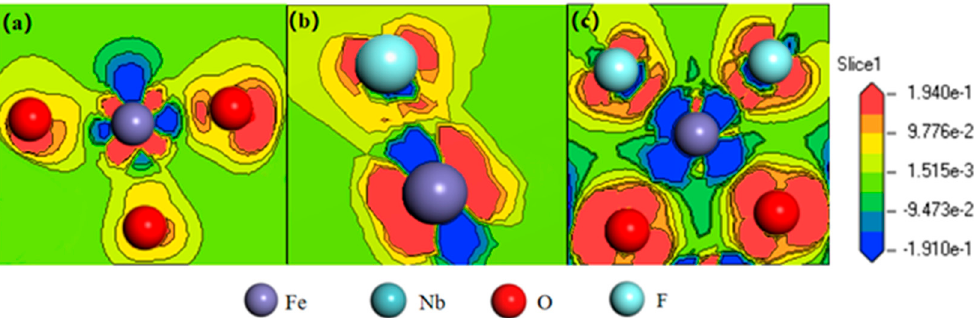
Figure 8. Electron density difference on (110) surface in different systems before and after acid leaching: ( a ) Fe atom combined with O atom on FeNb 2 O 6 (110) surface; ( b ) Fe atom combined an F atom on FeNb 2 O 6 (110) surface; ( c ) Fe atom combined 2 F atoms on FeNb 2 O 6 (110) surface.